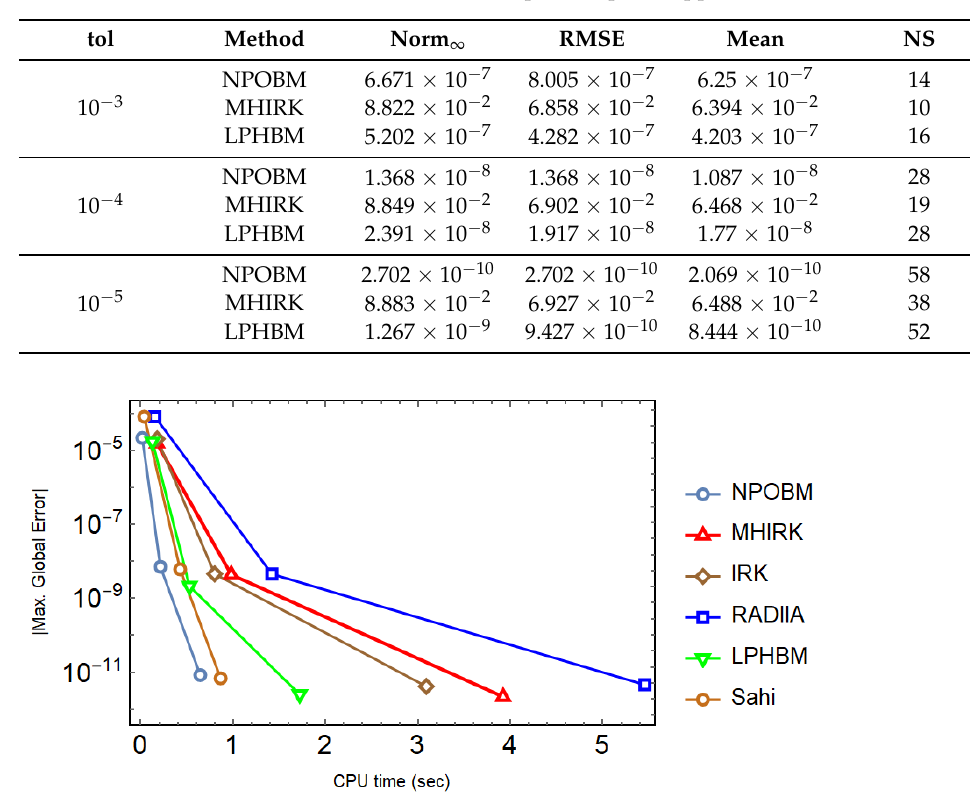
Table 12. Numerical results for Problem 3 with adaptive step-size approach while ∆ x ini = 10 − 6 . tol